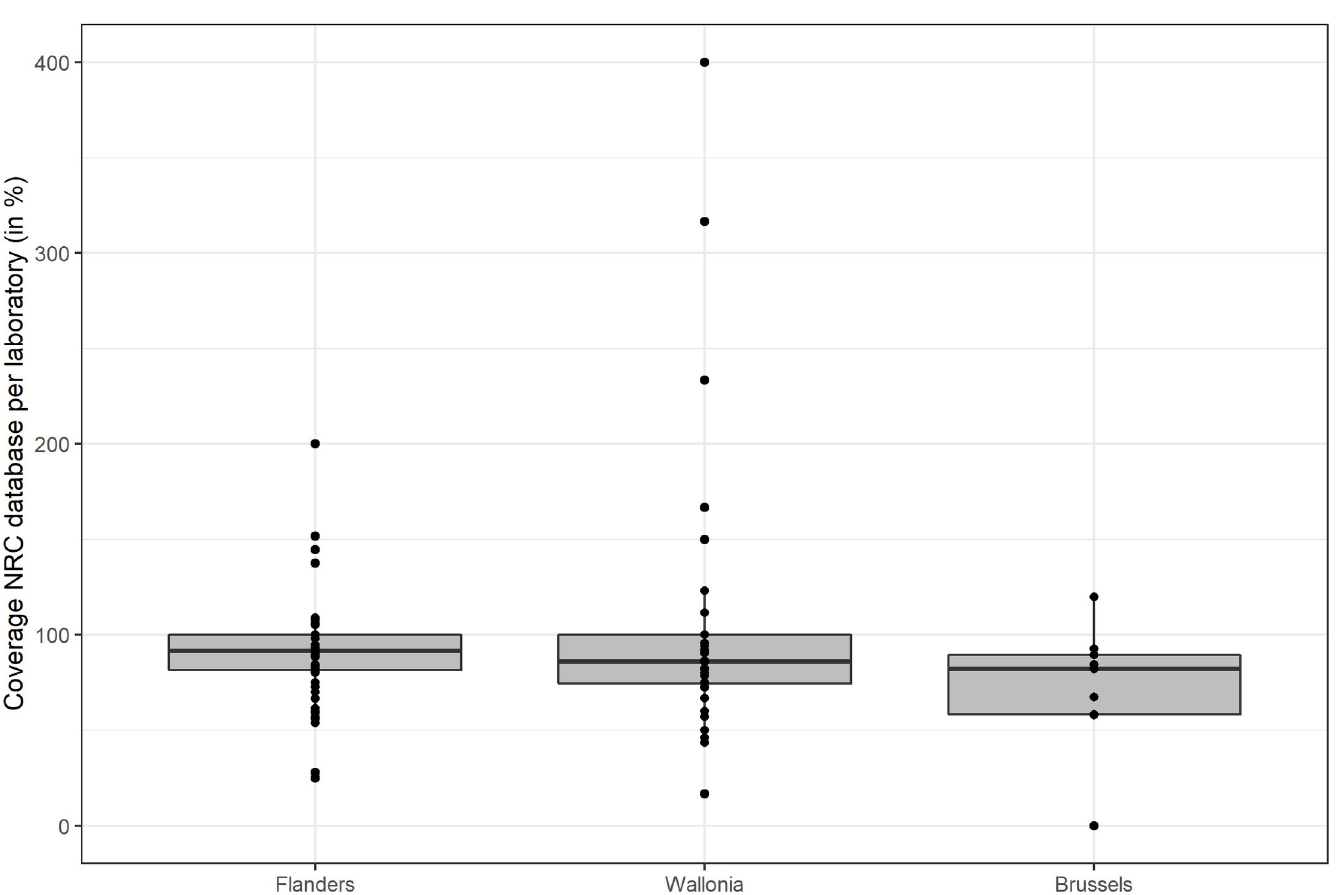
Fig 4. Coverage of the NRC surveillance system per licensed laboratory, per region, Belgium,